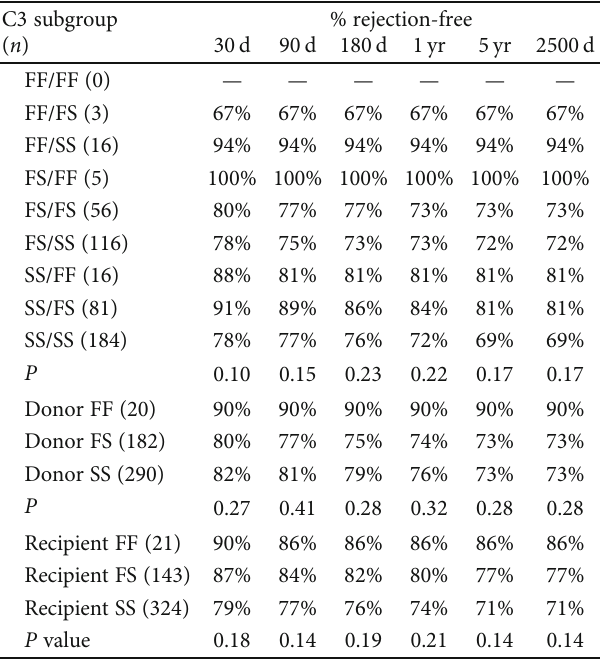
Table 5: Life tables for freedom from acute rejection. Acute rejection life table up to 2500 days posttransplantation in liver graft donors and recipients classi fi ed according to C3 genotype or presence of C3F